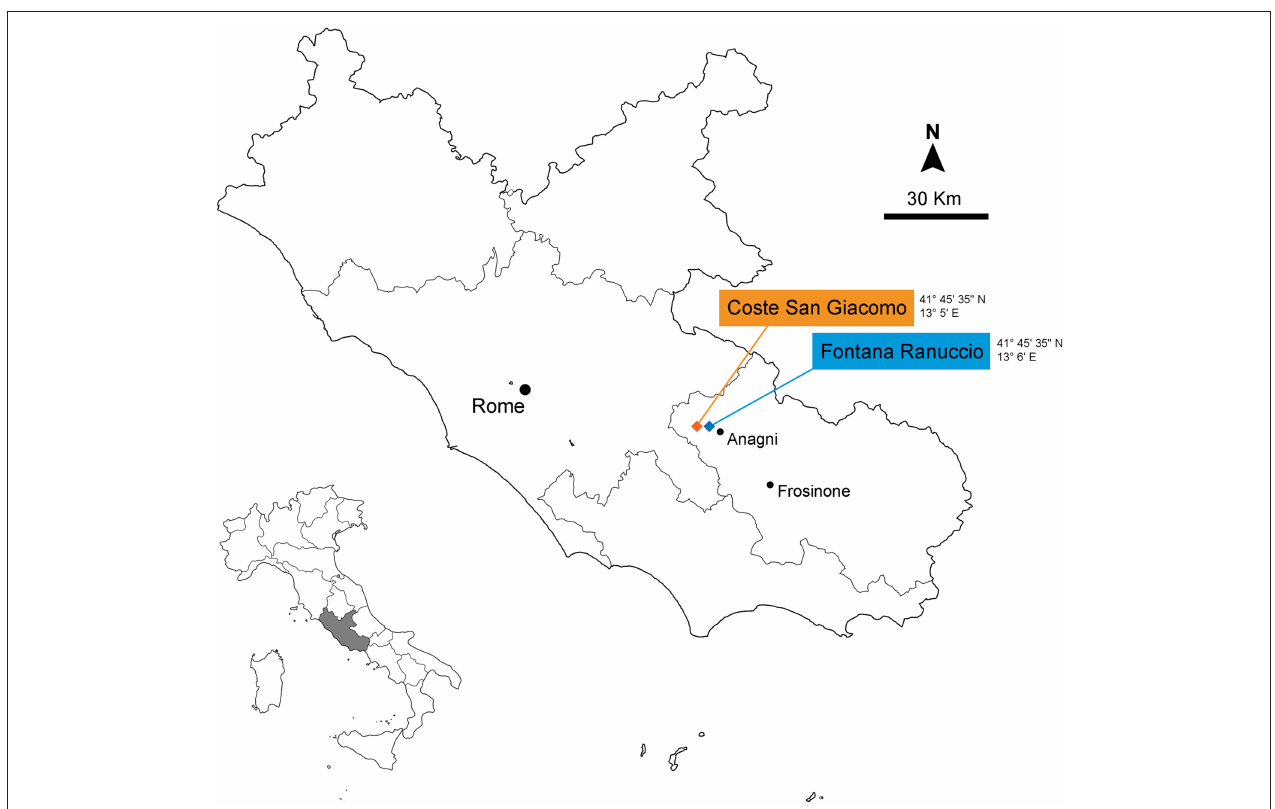
FIGURE 1 | Geographical location of the Coste San Giacomo and Fontana Ranuccio